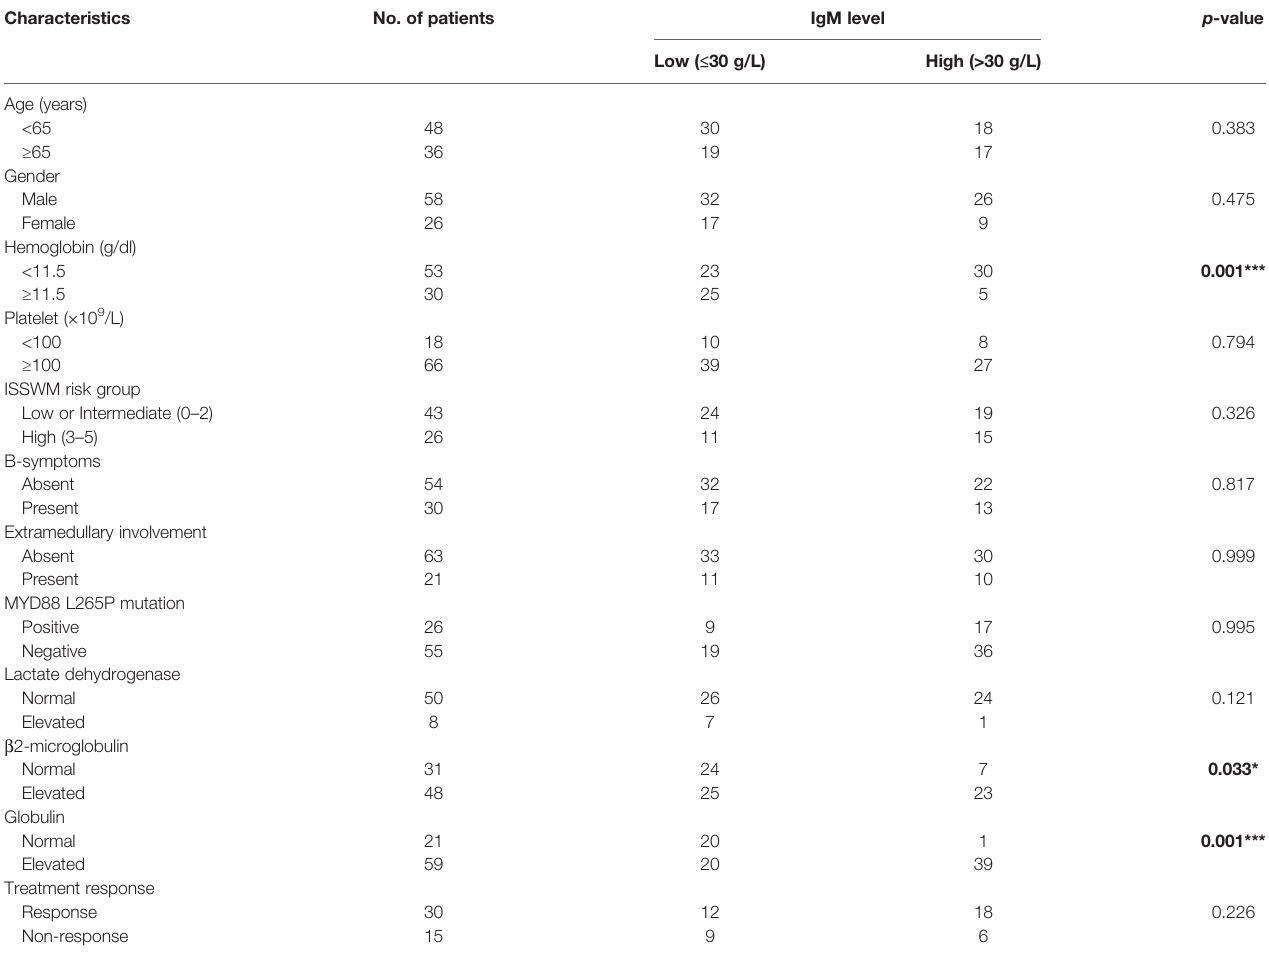
TABLE 4 | Comparative clinical and biological characteristics of WM/LPL based on IgM level.